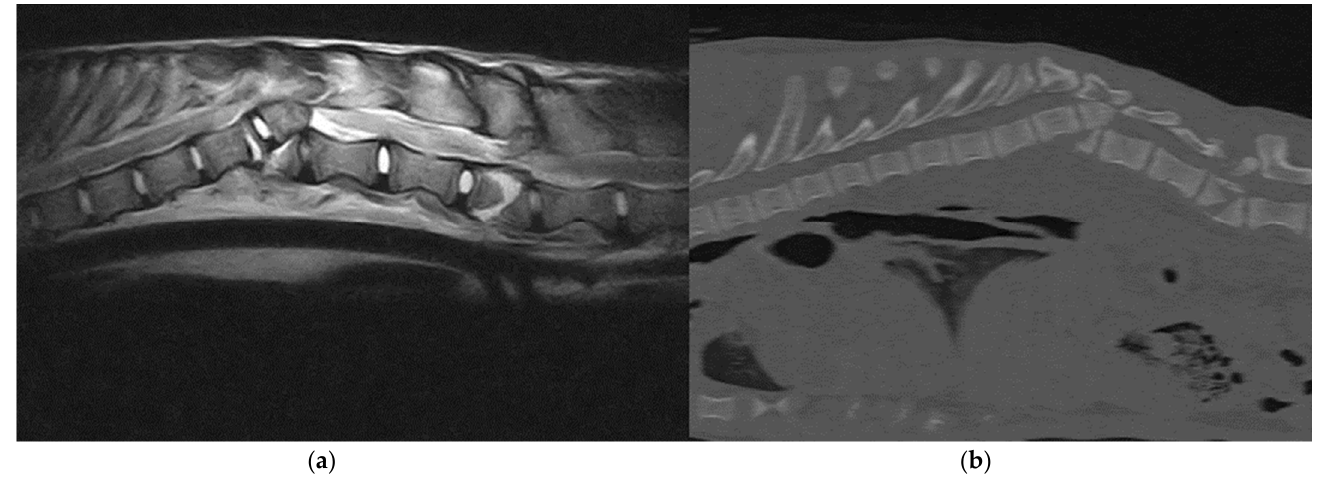
Figure 2. ( a ) Sagittal T2-weighted MRI and ( b ) sagittal bone window CT scan: A 6-month-old, fe- male, Italian wolf affected by vertebral fracture and luxation at the level T12 and L2. Italian wolf affected by vertebral fracture and luxation at the level T12 and